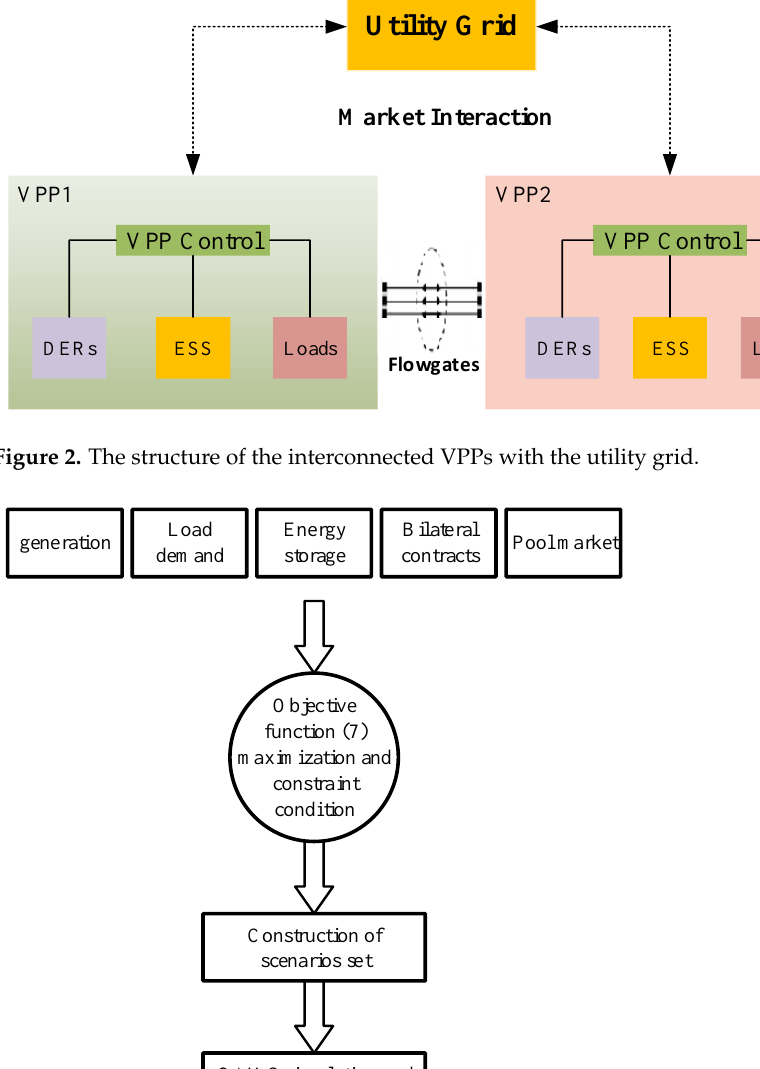
Figure 2. The structure of the interconnected VPPs with the utility grid.